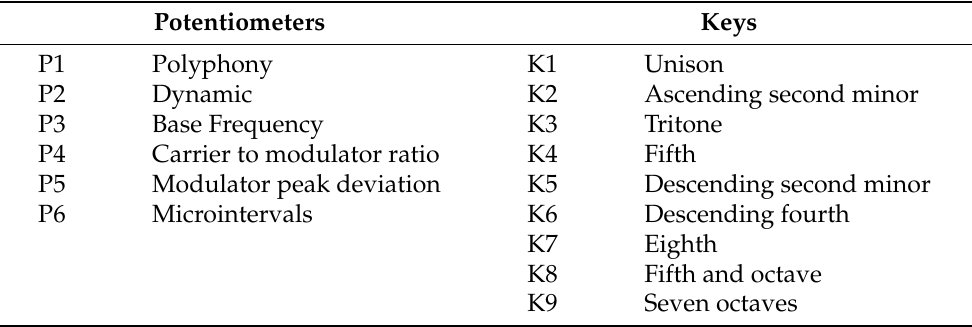
Table 2. Control parameters of Prometeo : potentiometers are used to input continuous values, and keys are used to select the harmonic